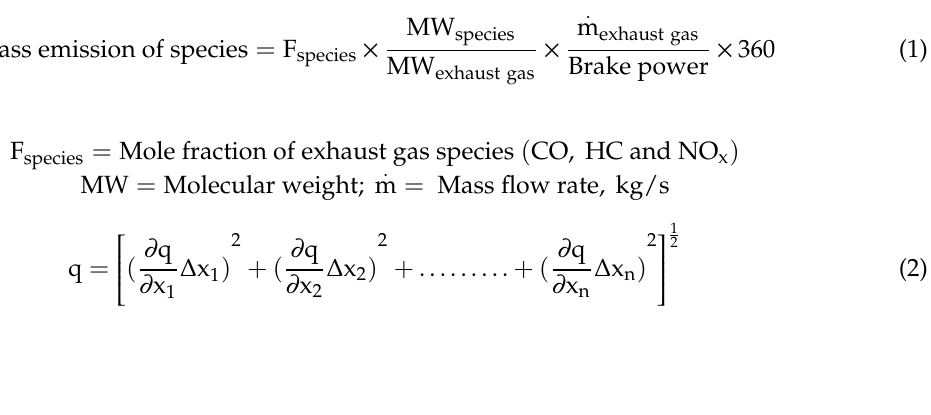
Table 5. Detailed experimental test matrix.